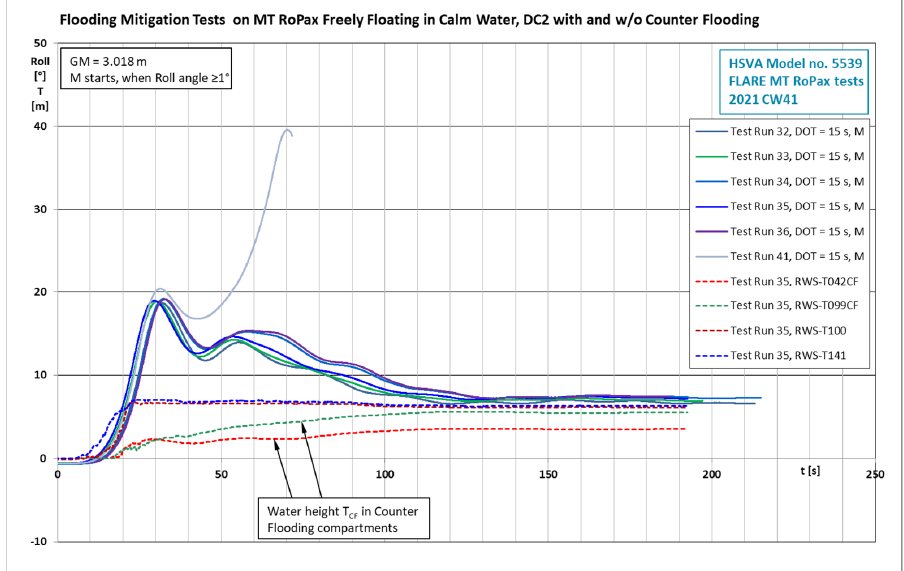
Figure 9. Damage Case 2 with damage opening time 15 s: Roll angle as a function of time with counter flooding (solid lines). The dashed curves below show the water height in the damaged compartments T100 and T141 and also in those for counter flooding T099CF and T042CF for Test Run 35. With GM 3.48 m, the ship survived in beam seas of significant wave height H S 3.5 m in 100% of the cases when the damage was opened in 15 s. Without mitigation, the sur ‐ vival rate was only 20%.